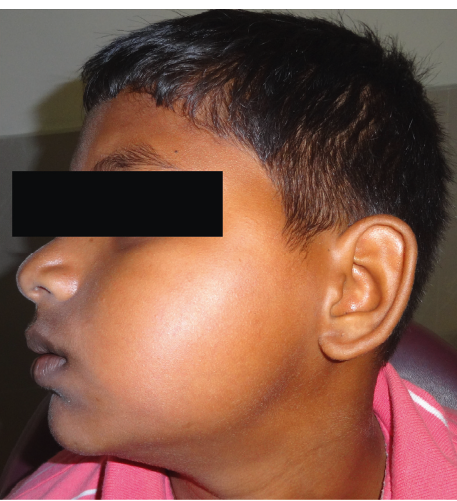
Figure 1: Clinical photograph showing diffuse swelling on the left side of the face.